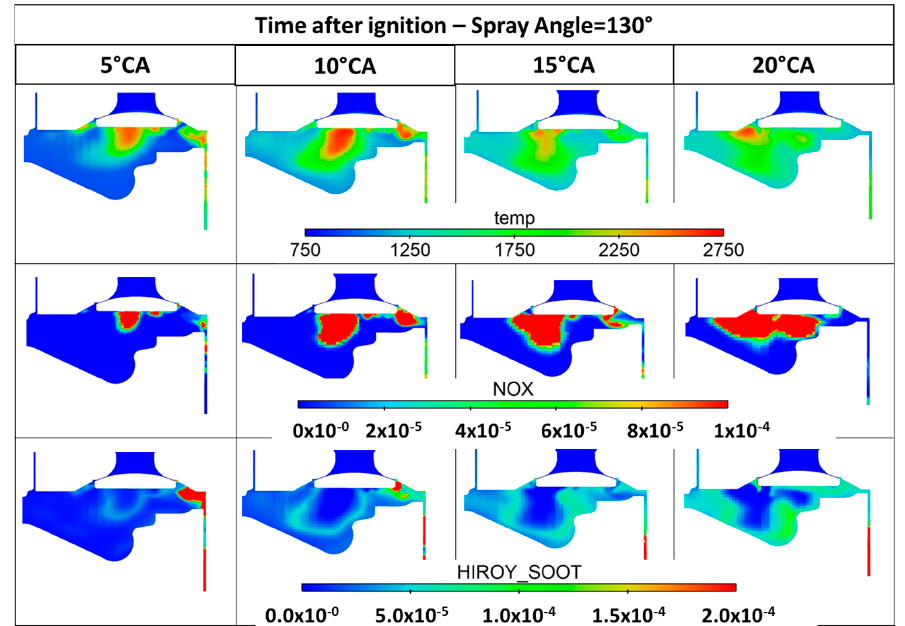
Figure 35. Evolution of in-cylinder temperature, NO x , and soot mass fraction contour plots in a plane formed by the cylinder axis and a spray axis at 5, 10, 15, and 20 °CA after SOIgn for an SIA of 130°.